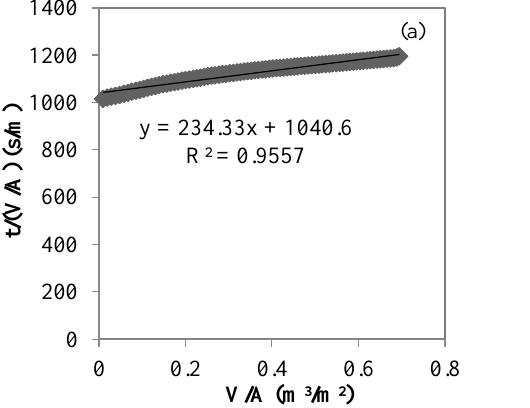
Figure 3. Cake layer model fitting for the MF process of a 10 mg/L kaolin solution ( a ) and the correlation between I and the feed kaolin concentration ( b ).